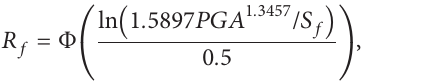
Figure 9: Embankment energy dissipations of the 27th combi- nation (F 1 � F 2 � F 3 � 0 and PGA � original